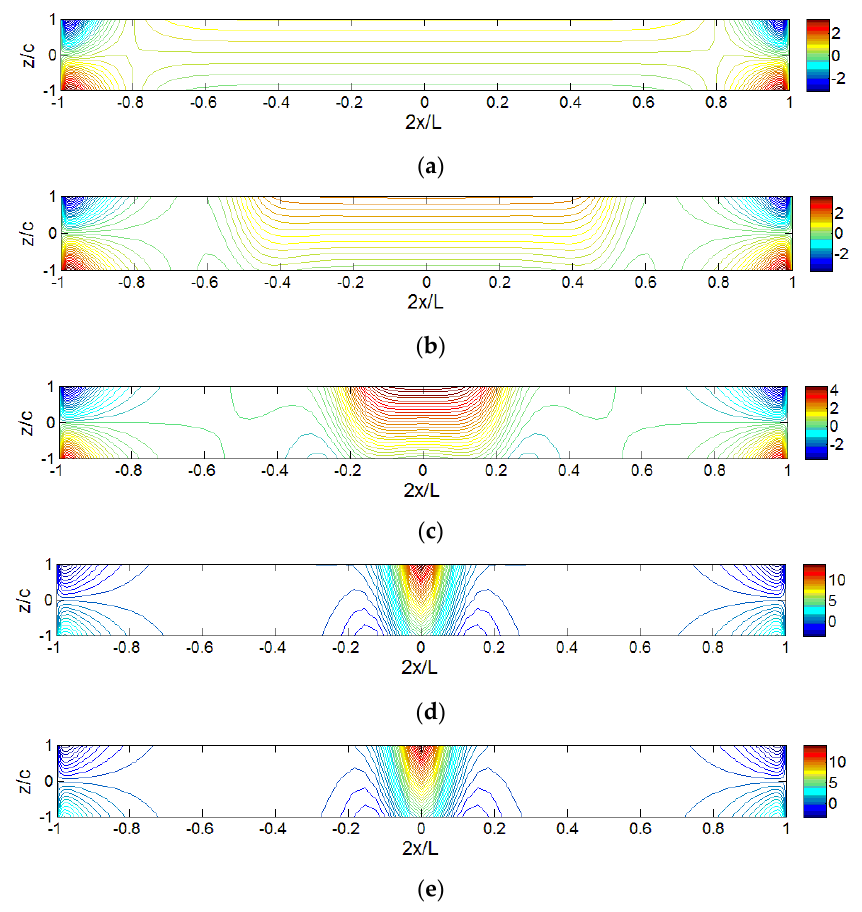
Figure 14. Iso-stress ( σ zz / q ) diagrams for sandwich panels under various locally distributed loads: ( a ) L p = L ; ( b ) L p = 0.5 L ; ( c ) L p = 0.2 L ; ( d ) L p = 0.01 L ; and ( e ) L p = 0.001.